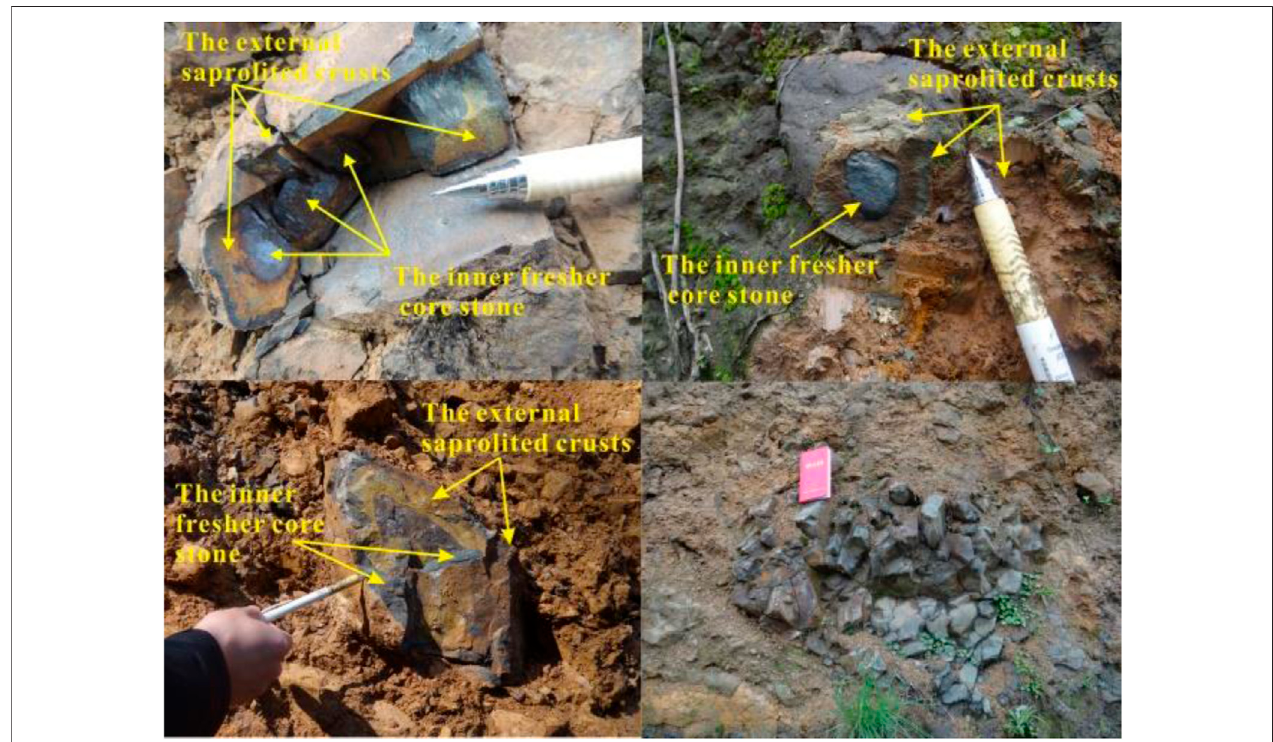
FIGURE 17 | Basaltic rocks present the structure the structure of soil sandwiching rock due to severe weathering.